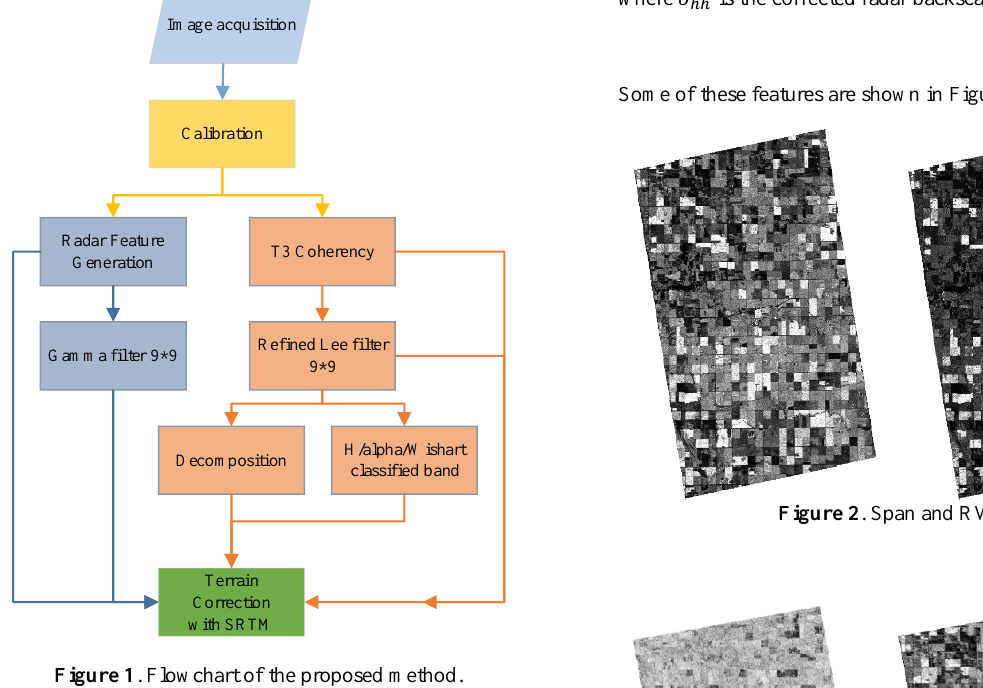
Figure 1 . Flowchart of the proposed method.